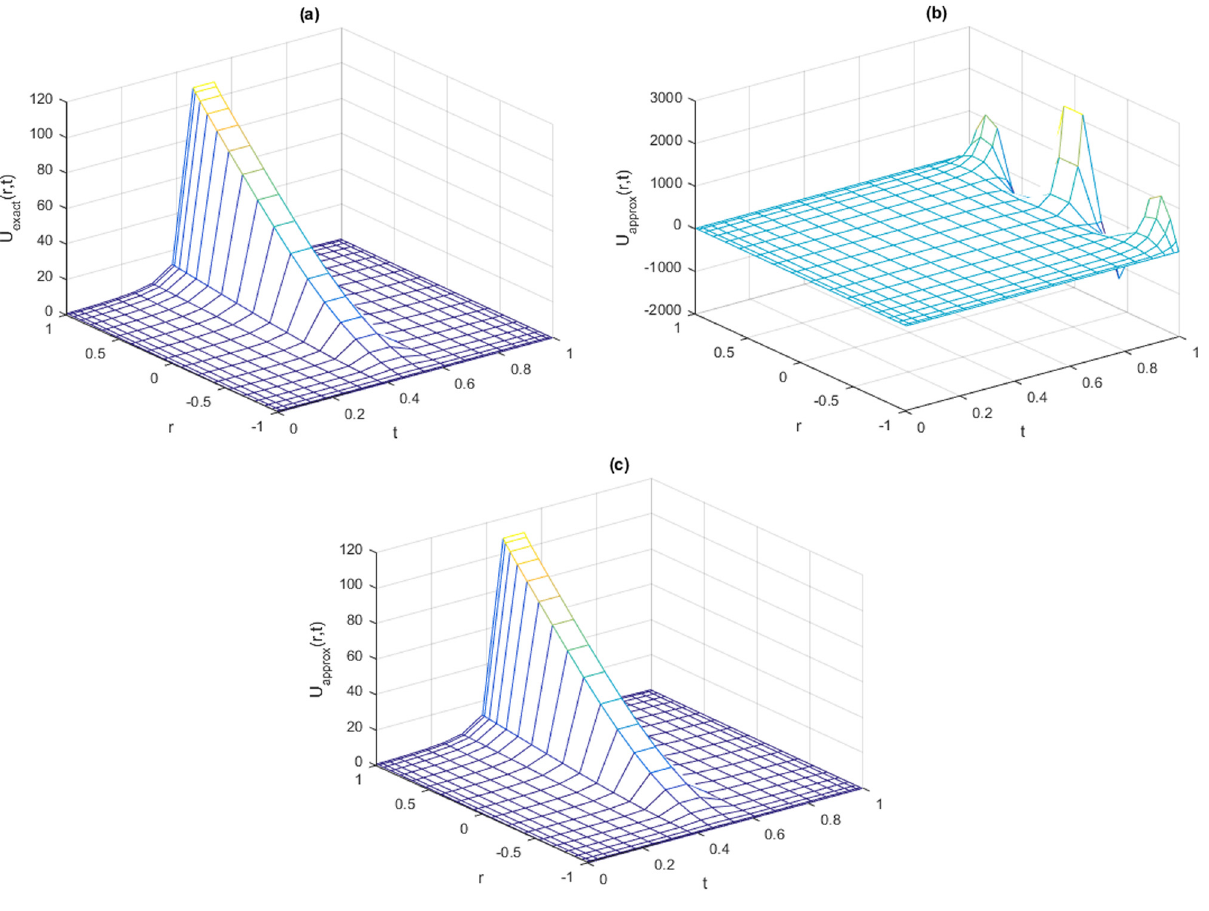
sin 2 ; ( b ) numerical solution with SM; and ( c ) numerical ( ) ( ) = 2 2 x y ( ) +